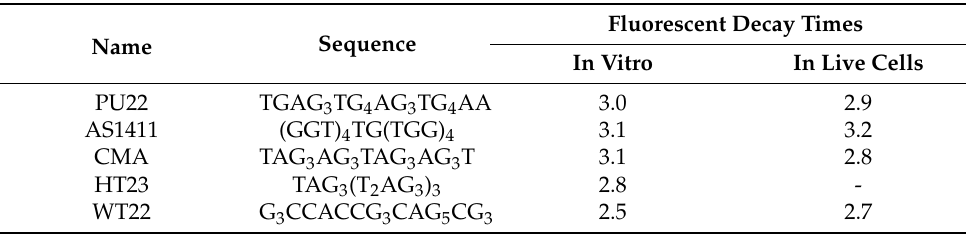
Table 1. The GROs used in this work and the center peaks of the o -BMVC decay times upon binding to these G4 structures.